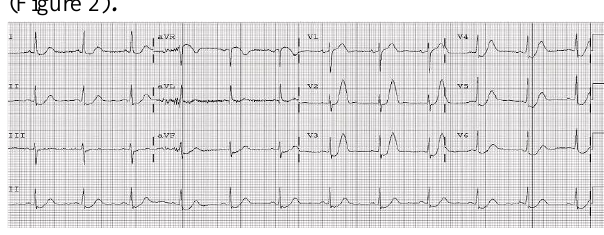
Figure 2 : 12-lead ECG showed upsloping ST segment depression with prominent and symmetrical T waves in the precordial leads and reciprocal ST segment elevation in aVR. Hemogram, plasma creatinine, urea and electrolytes tests were normal and troponin I was 0.15 ng/ml [Normal value (NV): less than 0.06 ng/ml].